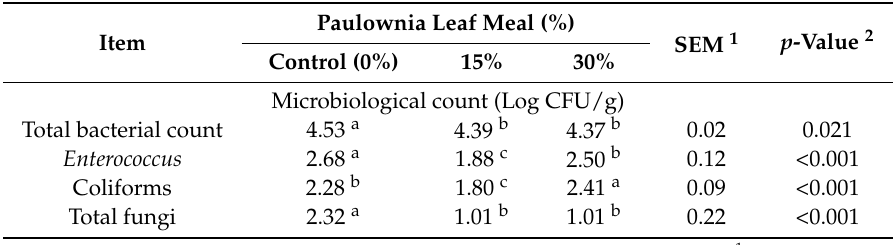
Table 7. Effects of paulownia leaf meal on total bacterial count and Enterococcus , coliform, and total fungi populations in the basal diet during feeding of growing New Zealand White rabbits.